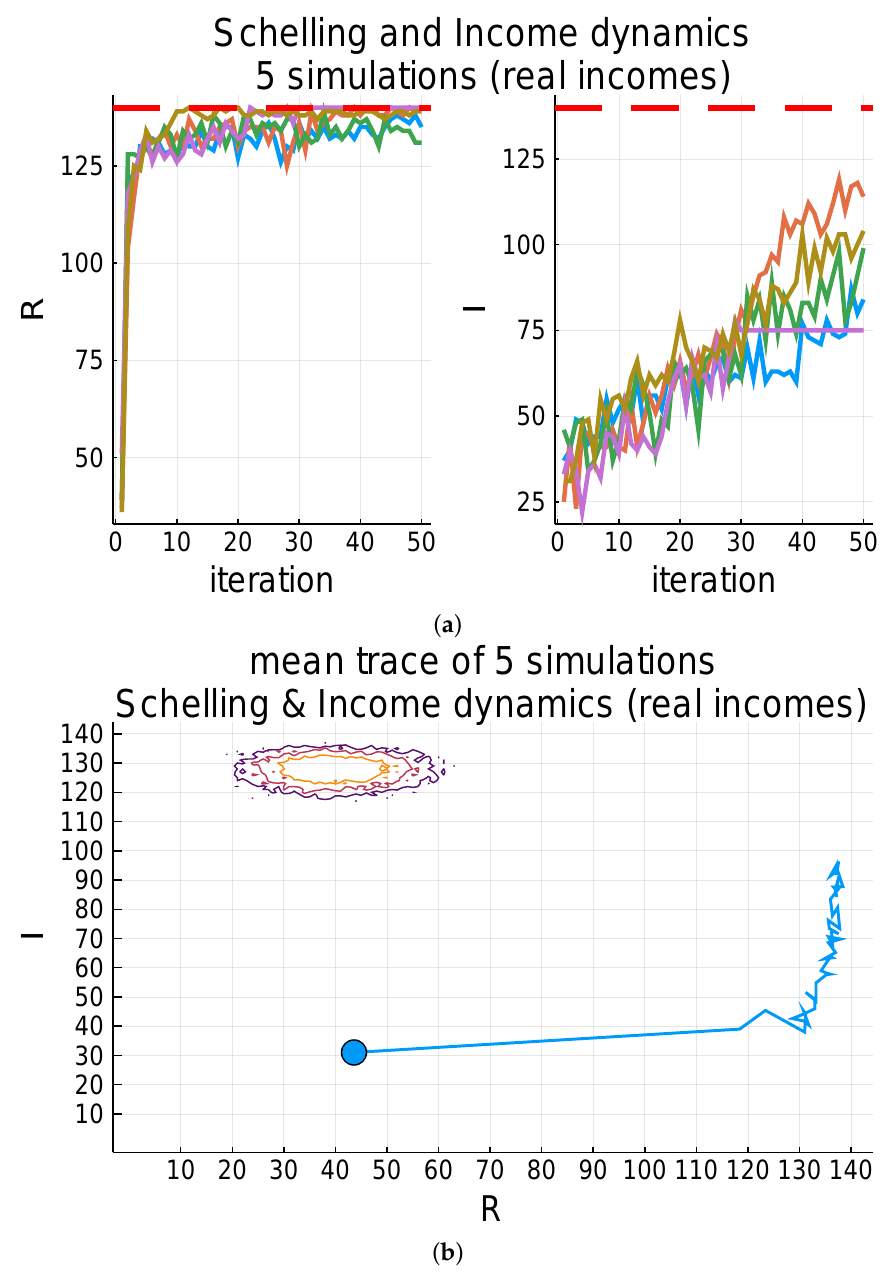
Figure 7. A very small dependence of the income homogeneity to the residential homogeneity is seen at lower homogeneity values with a very abrupt increase at values near the convergence. Subfigure ( a ) shows the trajectory of the overall grid homogeneity over simulation iterations for R and the grid income homogeneity I for the same iterations. Subfigure ( b ) shows the trajectory over both homogeneity variables with the contour levels of the sampled density of the space used to calculate the entropy of each point in the trajectory. Equation (12) was used for residential